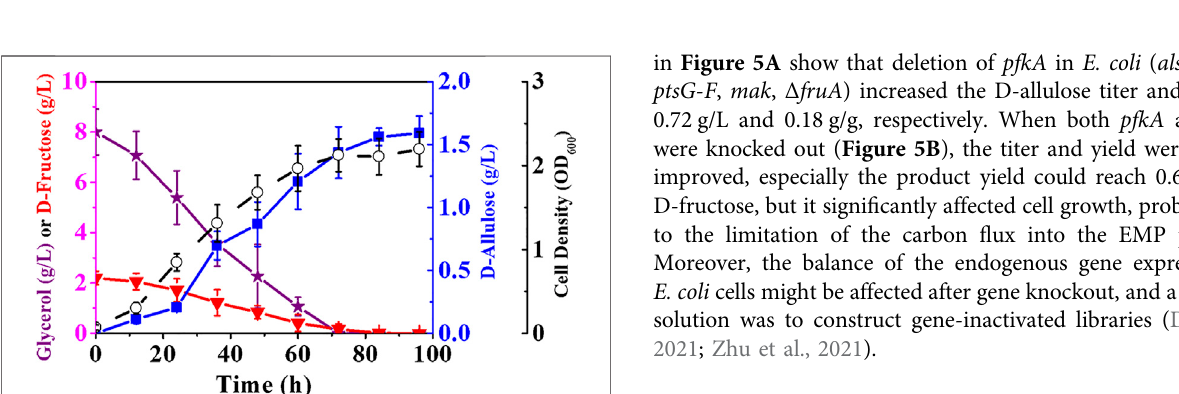
FIGURE 6 | Improvement of ATP supply in cell factory. (A) Intracellular ATP level, 1) E. coli ( Δ fruA , Δ pfkA , Δ pfkB ), 2) E. coli ( pckA , Δ fruA , Δ pfkA , Δ pfkB ), 3) E. coli ( pckA , Δ fruA , Δ pfkA , Δ pfkB ) under air-limited condition. (B) E. coli ( alsE , a6PP , ptsG - F , mak , pckA , Δ fruA , Δ pfkA , Δ pfkB ) cultured in buffered-LB medium with air- limitation condition at 37 ° C. Error bars, SD , n = 3 .